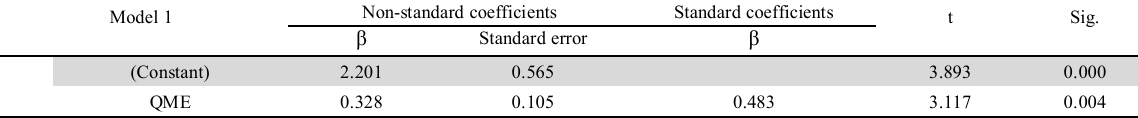
The summary of regression analysis on the effect of QME on KEI Model